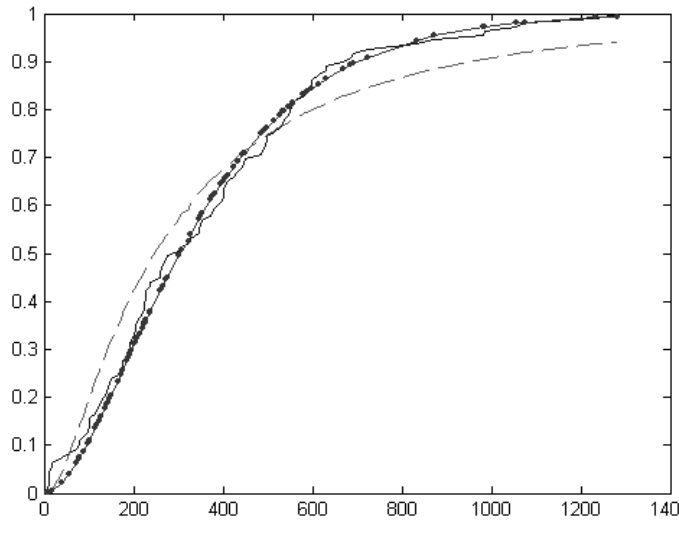
Figura 1 – Confronto fra tre distribuzioni